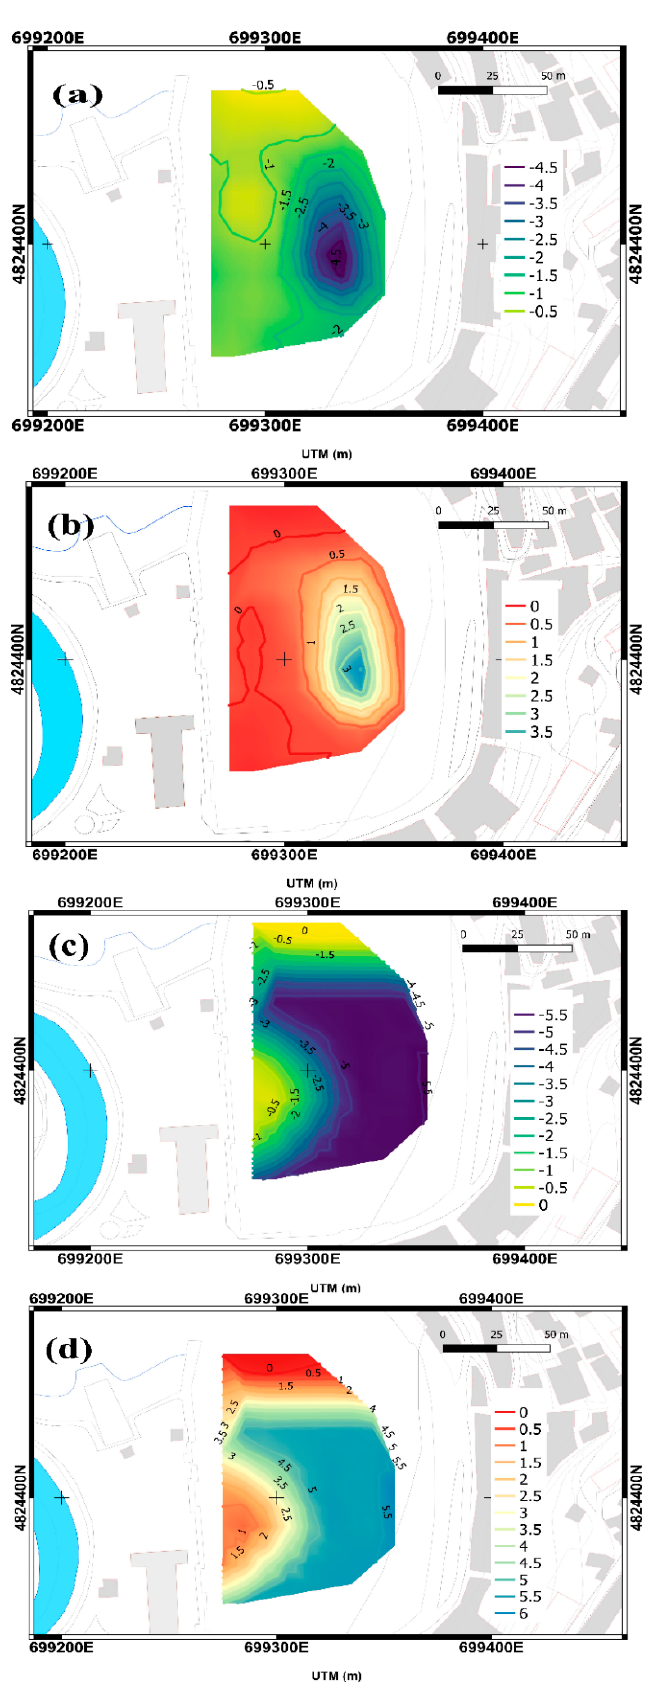
Figure 6. Difference in elevation of the bathymetries in the Port of Luarca between ( a ) 02/09/17 and 20/10/17, ( b ) 02/10/17 and 02/11/17, ( c ) 21/11/17 and 21/12/17, and ( d ) 21/12/17 and 24/02/18.